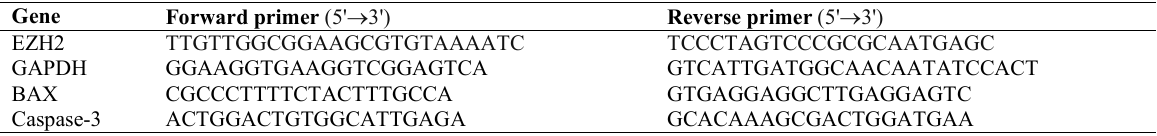
Table 1. Specific primer sets used in qRT-PCR Gene Forward primer (5' 